Question: Identify the chart type used in this figure.
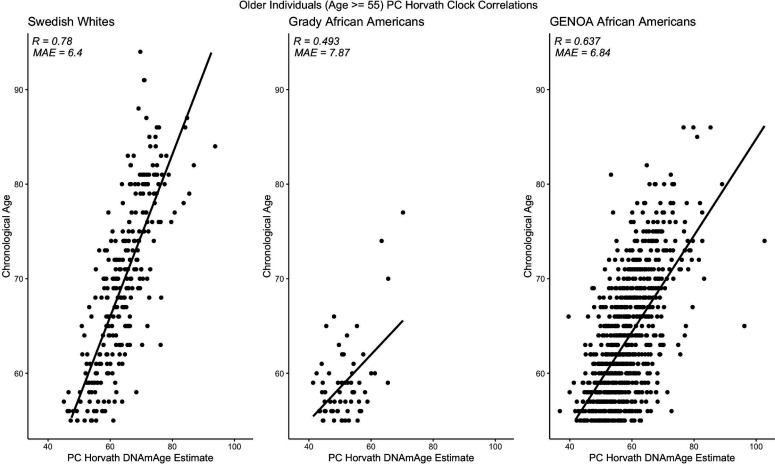
Answer: scatter